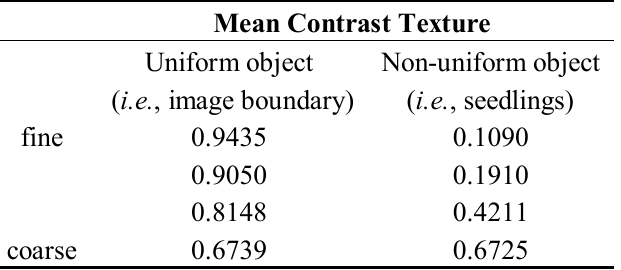
Table 2. Change in texture of uniform and non-uniform objects at different scales of